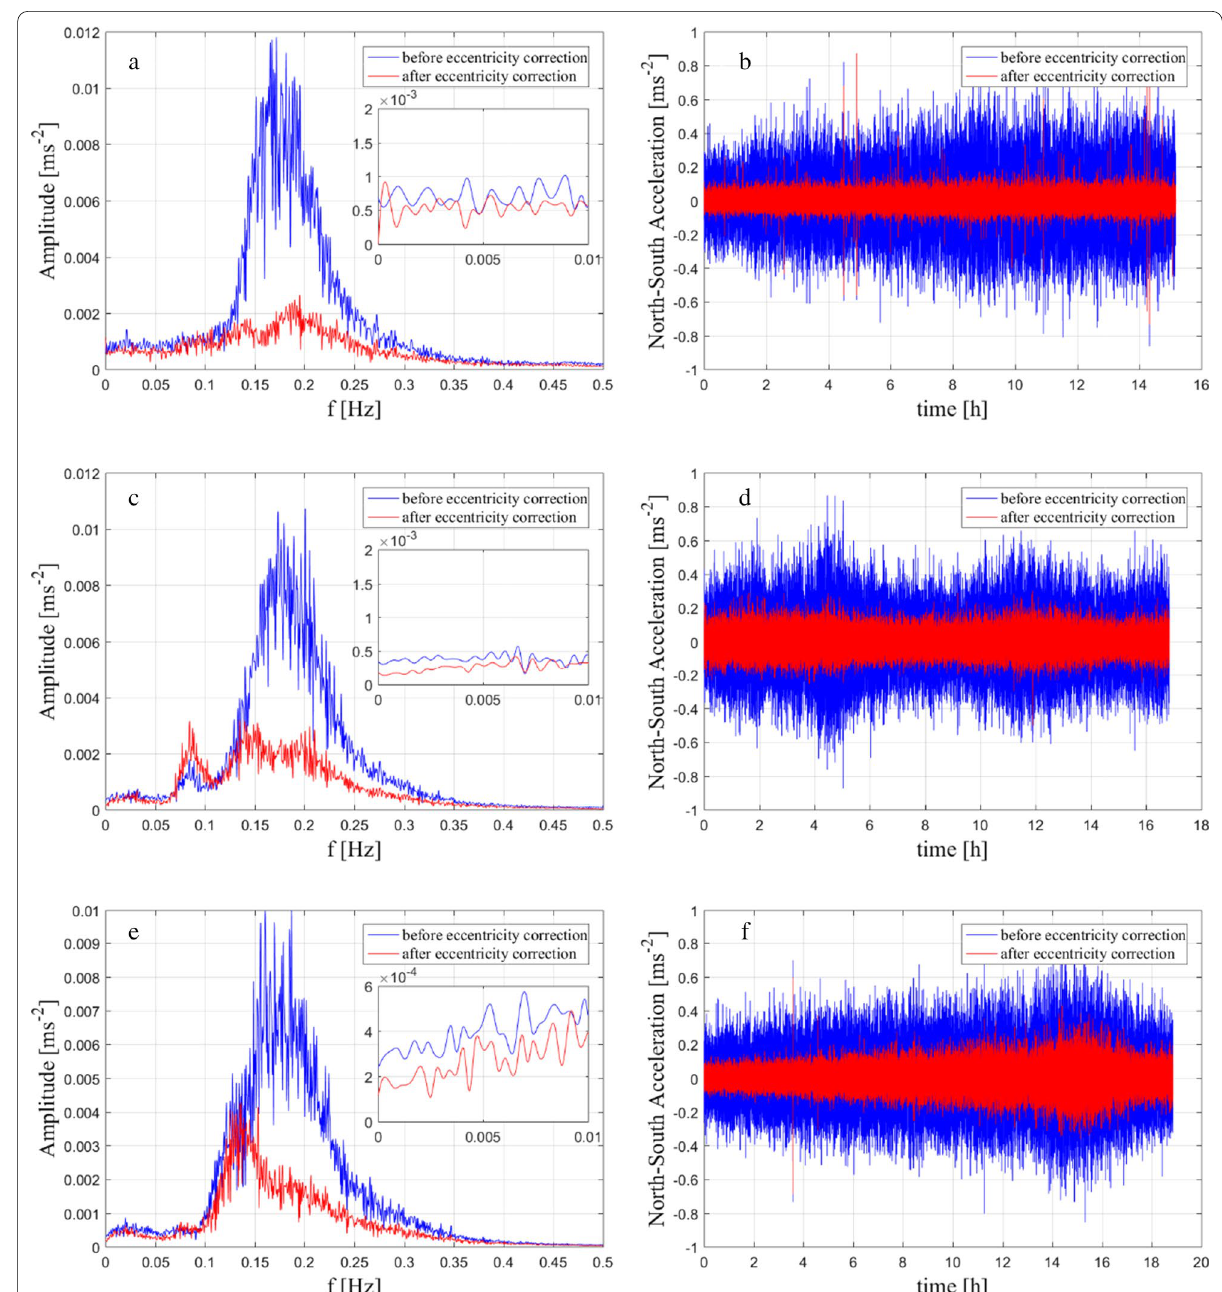
Fig. 14 Fourier time–frequency analysis of horizontal accelerations. a , c and e are the single-sided amplitude spectra of the horizontal accelerations of S1-1, X1-2 and X1-3, respectively; the small windows are enlarged views of the low-frequency band. b , d , and f are the corresponding time-domain horizontal